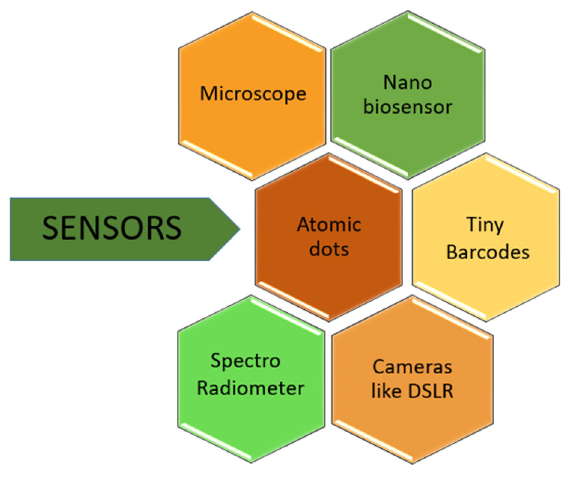
Figure 1. Different types of sensors.